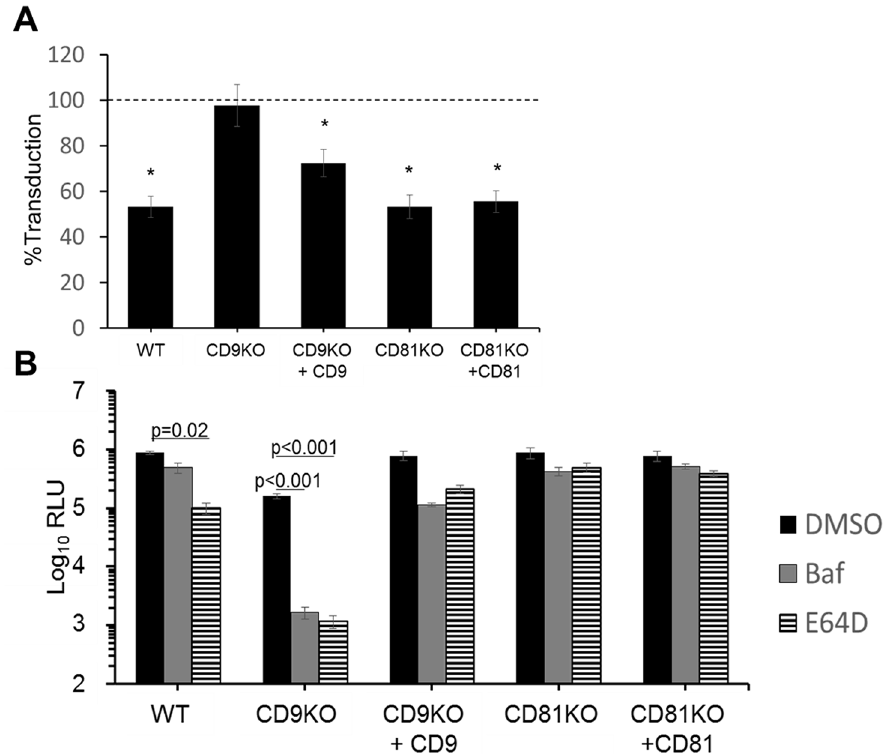
Fig 4. Proteasesensitivity of MERS transduction in tetraspanin KO cells. (A) WT or KO cells were transfected with DPP4 and either an empty vector or the complementing tetraspanin as indicated. The cells were pretreatedwith camostat before transduction with MERSpps. MERSpp entry was measuredby luciferase assays, and the percent transduction into camostat -treated cells was plotted relative to untreated cells (dotted line). * p < 0.05.(B) WT or KO cell lines were transfected with DPP4 and either an empty vector or the complementing tetraspanin as indicated. The cells were pretreatedwith bafilomycinor E64D before transduction with MERSpp. MERSpp entry was measuredby luciferase